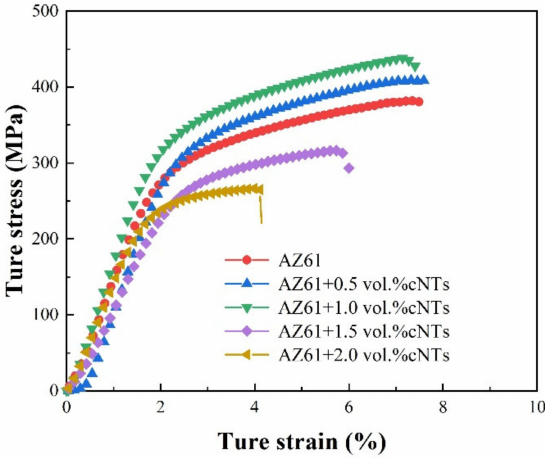
Figure 6. Typical compressive stress-strain curves of composites with different CNT contents.